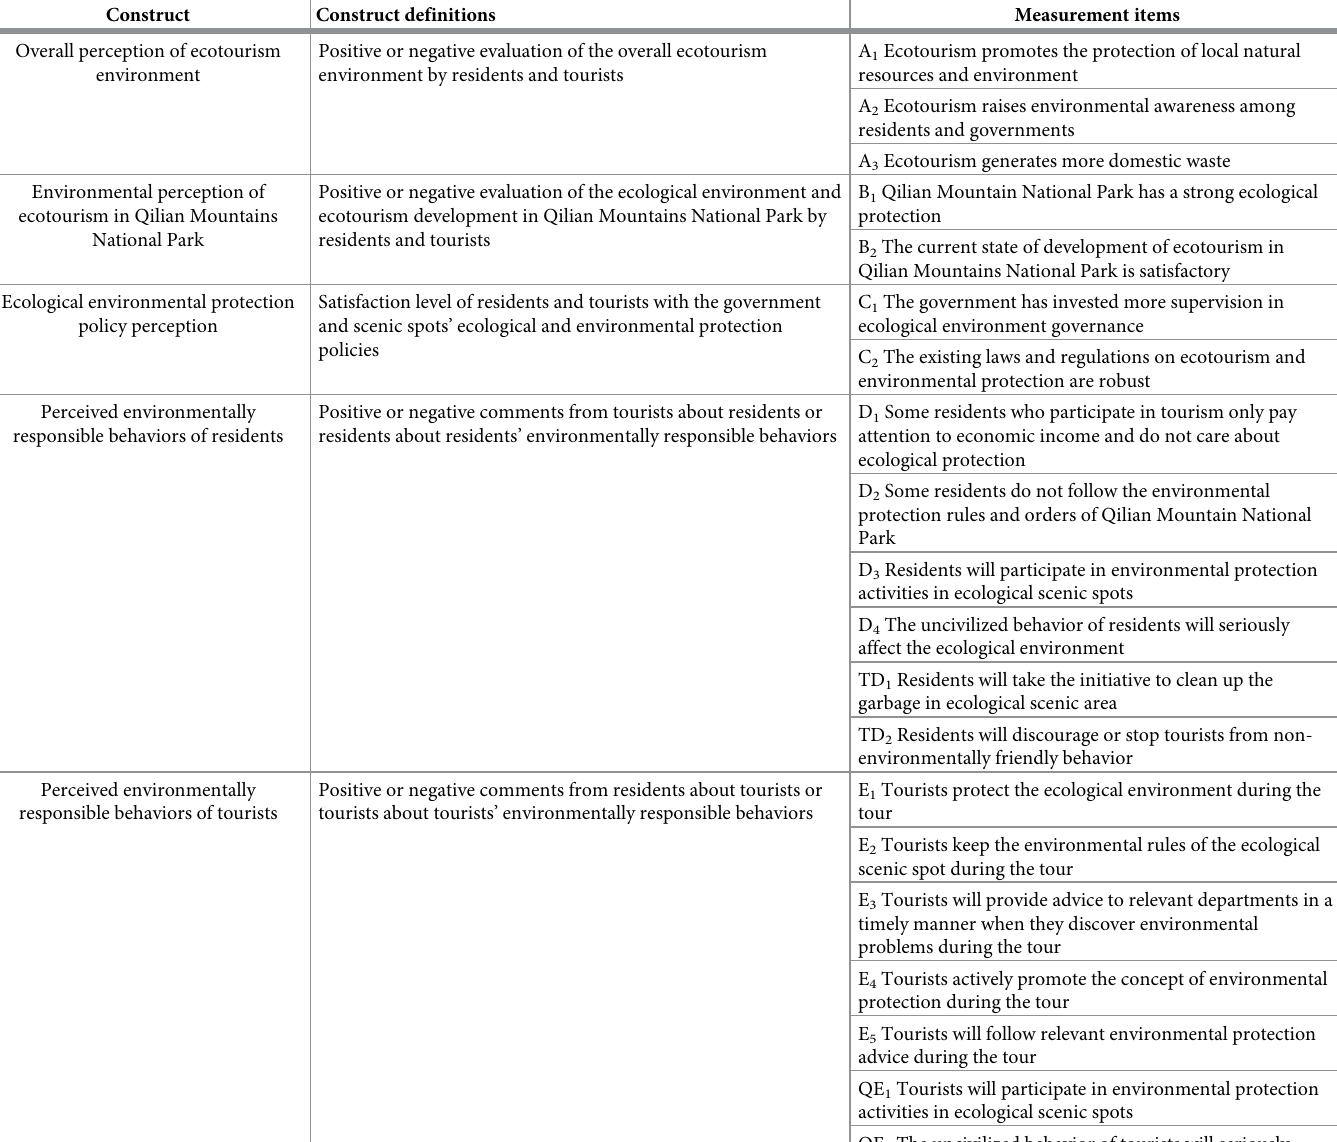
Table 1. Study construct definitions and measurement